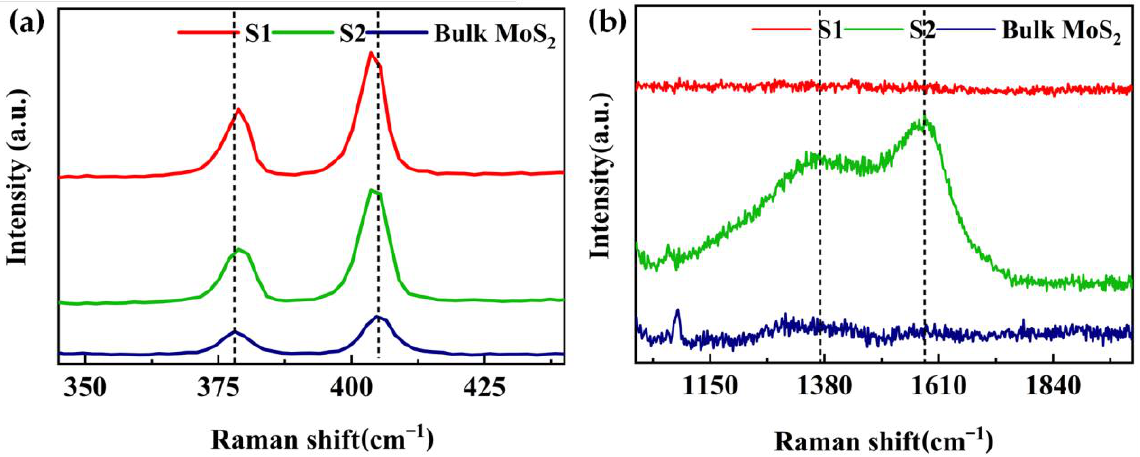
Figure 2. Raman spectra of the bulk MoS 2 , S1 and S2. ( a ) Enlargement of the MoS 2 peaks E 1 2g and A 1 g and ( b ) Enlargement of the MoS 2 peaks from 1150 cm − 1 to 1840 cm − 1